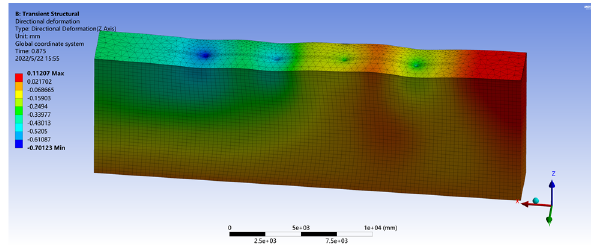
Figure 7. Road deformation map during vehicle driving.